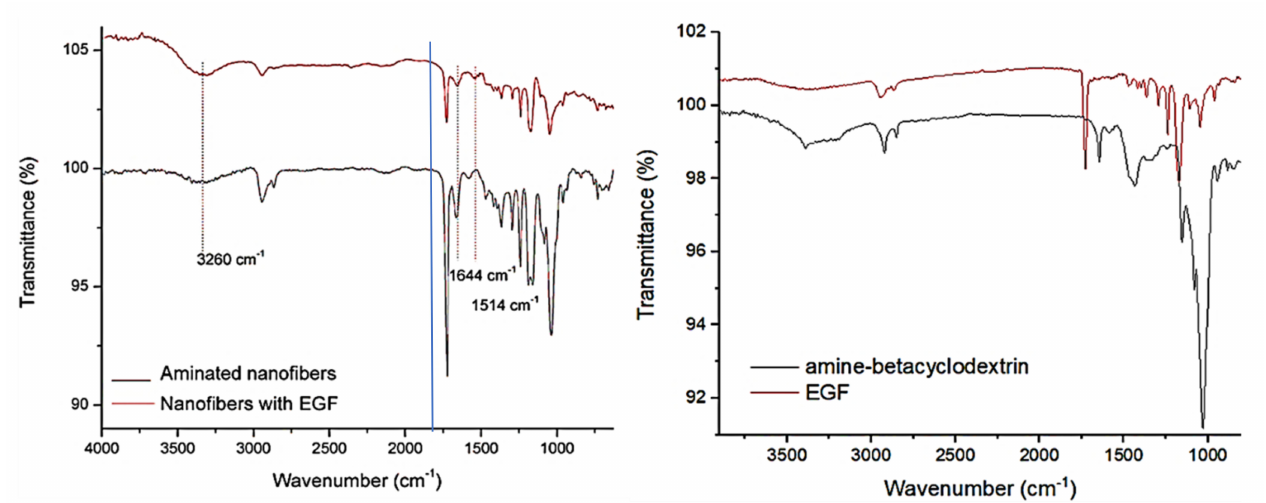
Figure 1. Fourier transform infrared with attenuated total reflection (FTIR) spectra of electrospun materials with and without attached epithelial growth factor